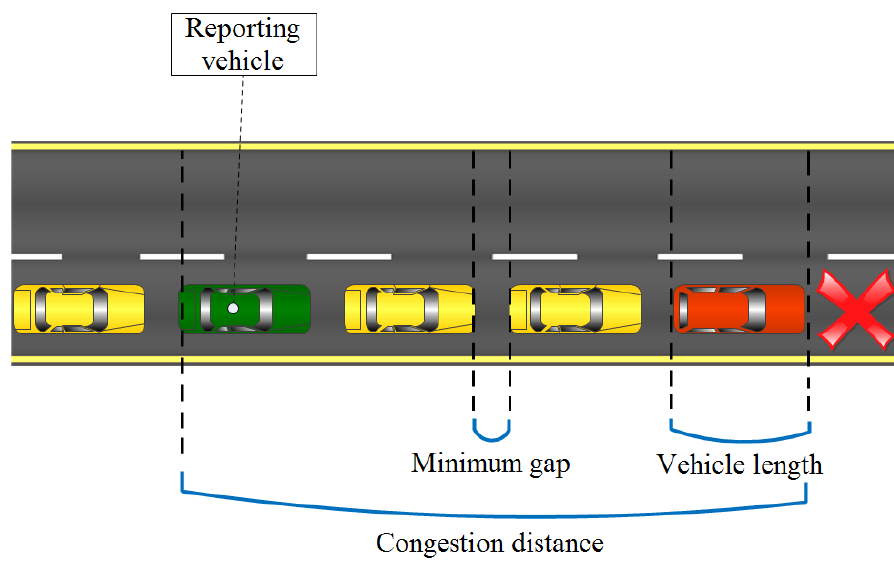
Figure 5. Density estimation